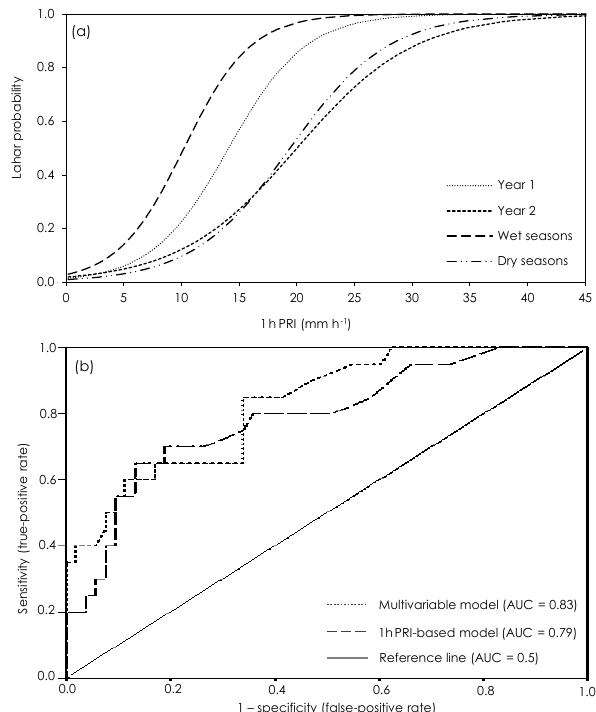
Figure 7. Assessment of binary-logistic-regression-based lahar probability estimation models in the Belham valley, Montserrat. (a) Illustration of four binary-logistic-regression-based lahar prob- ability estimation models created from year 1, year 2, wet season and dry season data. (b) ROC curves assessing the lahar forecasting performance of an exclusively 1h peak rainfall intensity (1hPRI)- centric logistic-regression-based lahar probability estimation model and a multivariable (1hPRI, antecedent rainfall and long-term cu- mulative rainfall)